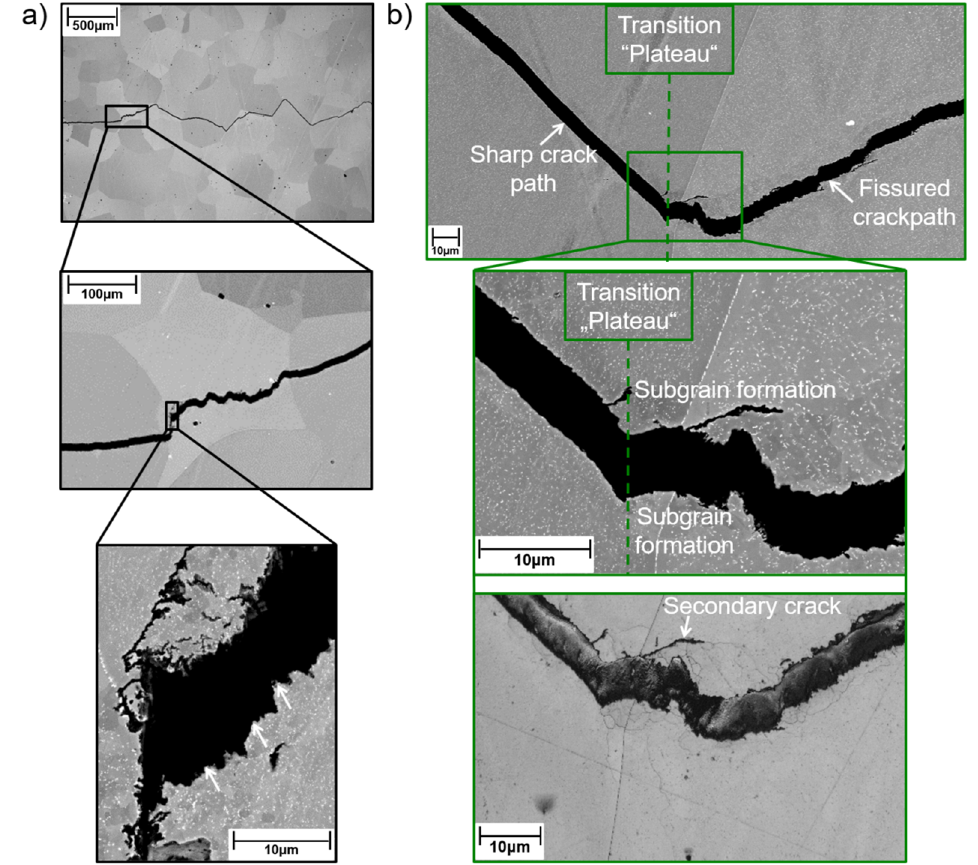
Figure 10. SEM images depict crack path and sub-grain formation ( a ) in the “kink” (da/dN ↓ / Δ K ↑ , marked in Figure 7) and ( b ) at the transition from the Δ K ↑ /da/dN ↑ region into one of the “plateaus” (da/dN ~ constant at Δ K ↑ ; marked by the green boxes in the cyclic crack growth curves in Figure 7).